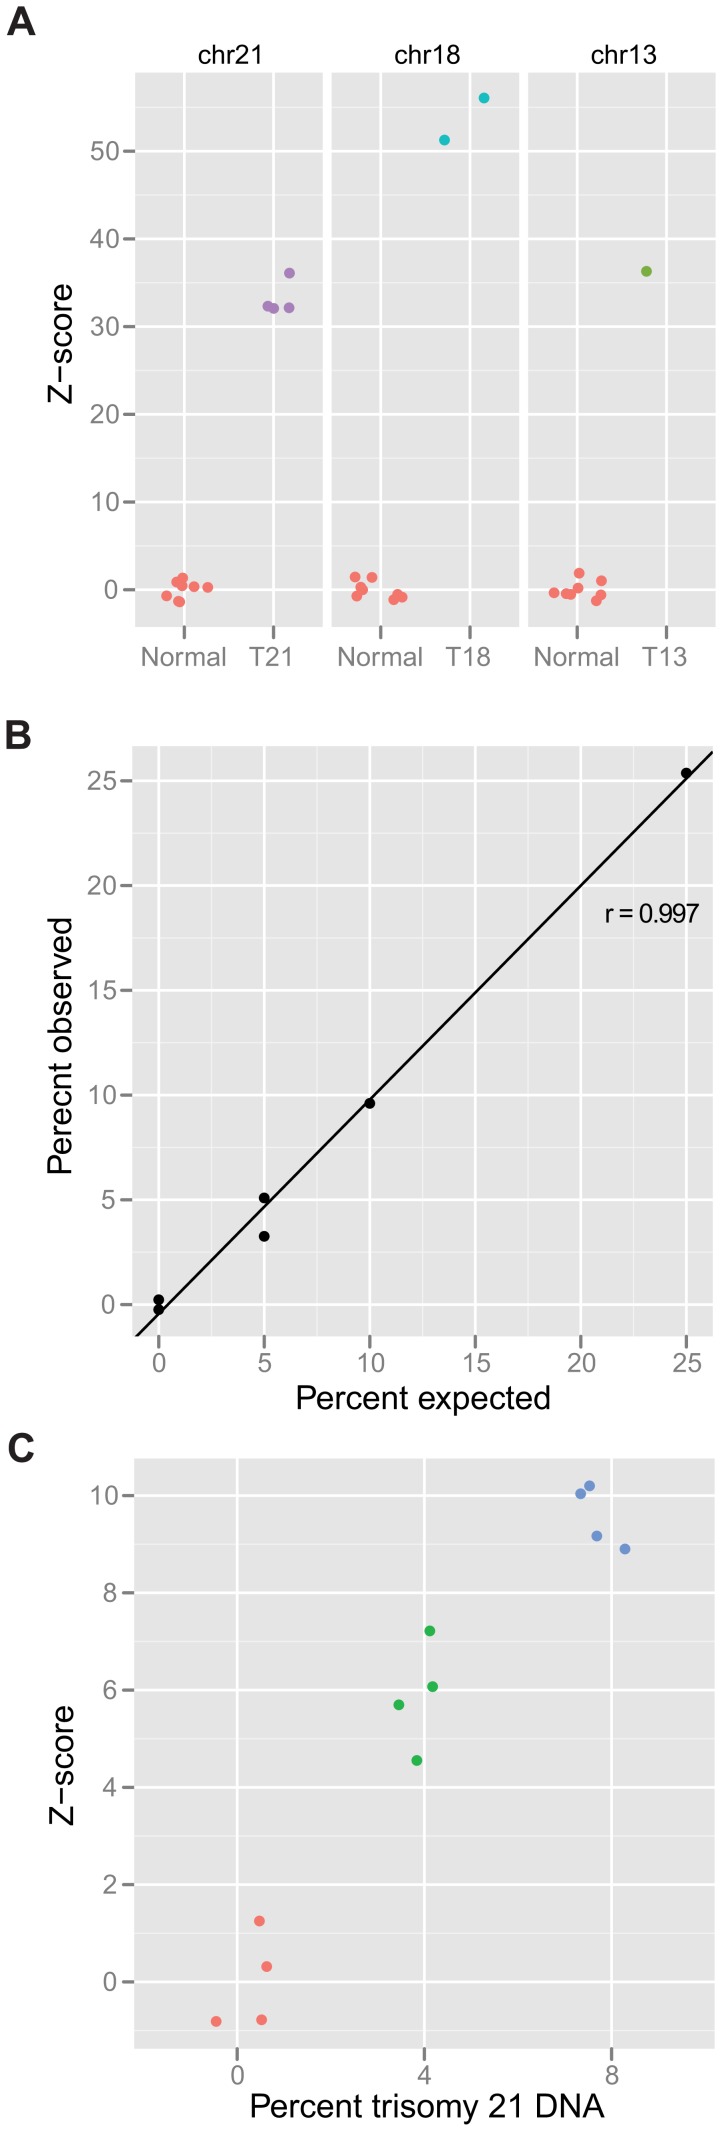
Accurate discrimination of euploid DNA samples from those containing trisomic DNA.(A) Comparison of z-scores from patients with trisomy 21 (n = 4), trisomy 18 (n = 2), and trisomy 13 (n = 1) with eight normal spleen or peripheral blood white blood cell (WBC) DNAs. The z-scores displayed represent the relevant chromosome for the comparison. The maximum z-score observed for any of the compared normal chromosomes was 1.9 (chr13). (B) Control WBC DNA was analyzed alone (n = 2) or when mixed with DNA from a patient with trisomy 21 at 5% (n = 2), 10% (n = 1), or 25% (n = 1) levels. A tight correlation existed between the expected and observed fractions of extra chromosome 21 (r = 0.997 by Pearson correlation test, n = 6). (C) Control WBC DNA was analyzed alone (z-score range: −0.8 to 1.3) or when mixed with DNA from a patient with trisomy 21 at 4% (z-score range: 4.5 to 7.2) or 8% (z-score range: 8.9 to 10.) levels. Each experiment in (C) was performed in quadruplicate.